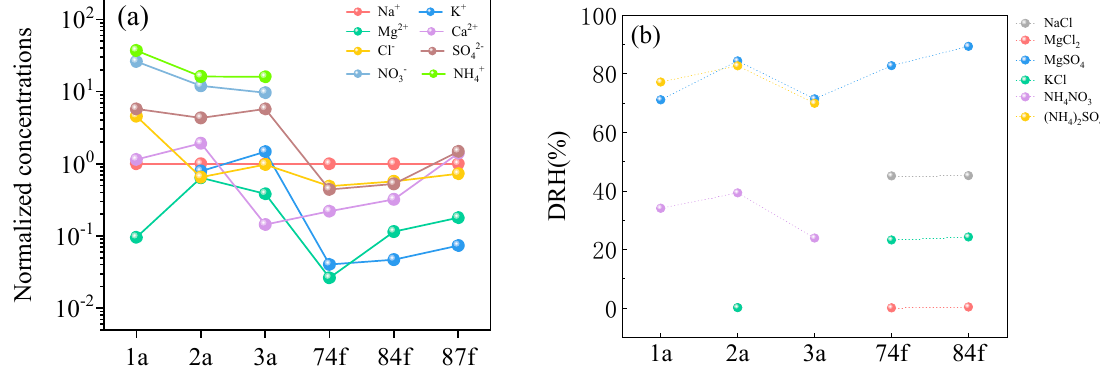
Figure 9. ( a ) Normalized concentration of ions. ( b ) Modeled DRHs of size salts in five aerosol samples. The 1a–3a are aged salt aerosol particles [16]; 74f, 84f, 87f are fresh salt aerosol particles [6]. Based on the ionic concentrations, the DRHs of the aged and fresh salt samples are calculated and shown in Figure 9b. The hygroscopicity of aged aerosol is dominated by the NH 4 NO 3 component, while the fresh salt particles are regulated by MgCl 2 , like the brine samples. Ageing strongly alters the hygroscopic property of salt particles. Note that not all the salt components deliquesce in the aged cases, i.e., IAP never reaches IAP sat below 100% RH, e.g., MgCl 2 , NaCl, and KCl in the aged samples.